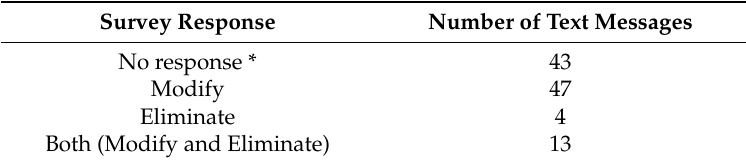
Table 4. Expert panel survey summary of text messages ( n = 107 texts).